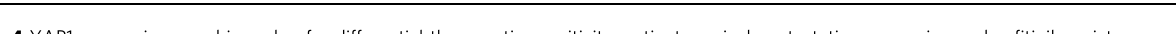
Fig. 4 YAP1 expression as a biomarker for differential therapeutic sensitivity, patient survival, metastatic progression and ge fi tinib resistance. a Protein- protein interaction ( PPI ) network of differentially expressed genes between HN137-Pri and HN137-Met related to inhibitor-of-apoptosis (IAPs). The width of the edges is proportional to the number of evidences supporting the interaction. Nodes in yellow denotes that the genes that are upregulated in HN137- Met, whereas blue denotes downregulation. The size of the nodes is proportional to magnitude of fold change. b Circos plot depicting global ampli fi cation ( red ) and deletion ( blue ) in HN137-Pri ( inner track ) and HN137-Met ( outer track ) genomes. Region of ampli fi cation found on chromosome 11 in HN137-Met is shown on the right . c Western blot for YAP1 expression in HN137-Pri and HN137-Met cells. Asterisk denotes band depicting low level of YAP1 expression in HN137-Pri cells. d IHC staining of HN137-Pri and HN137-Met tissue specimens for YAP1 expression. Bottom panels display higher magni fi cation images of regions marked in black boxes . Positive cells were visualized by DAB staining. Scale bar , 2 mm ( top panel ), 100 μ m ( bottom panel ). e Dose-response curve for HN137-Pri, HN137-Met and HN137-Pri cells stably overexpressing YAP1 (HN137-Pri YAP1) to YM155 ( left panel ) and ge fi tinib ( right panel ). Experiments were performed at least twice, in triplicates. Cell viability was determined using CellTiter-Glo reagent. Error bars represent mean ± s.d. f Timeline for patient HN137 from surgery and post-operative chemotherapy (Dec), ge fi tinib treatment (June) till development of ge fi tinib-resistant dermal metastasis. IHC staining for YAP1 in HN137-Pri, HN137-Met and HN137 ge fi tinib-resistant dermal biopsy sample (HN137-Gef-R). Positive cells were visualized by DAB staining. Scale bar , 100 μ m. g Representative IHC staining for YAP1 in ( n = 166) OSCC patient set from Iyer et al. 21 . Graded intensities (0, 1+, 2+ and 3+) of YAP1 nuclear staining shown in the upper right corner ( left panel ). Scale bar , 100 μ m. Kaplan-Meier survival analysis for YAP1 expression (positive: 1+, 2+, 3+; negative: 0) was done. Overall survival from diagnosis ( middle panel ) (Log-rank P value = 0.01), and disease-free survival from treatment ( right panel ) (Log-rank P value = 0.04) are depicted in number of days. h An overview of scaling the proposed “ phenotype-driven precision oncology ” approach to identify prognostic molecular signatures for treatment